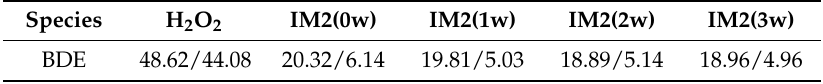
Table 3. Calculated BDEs of the O-O bond in H 2 O 2 and the second intermediates a . Species